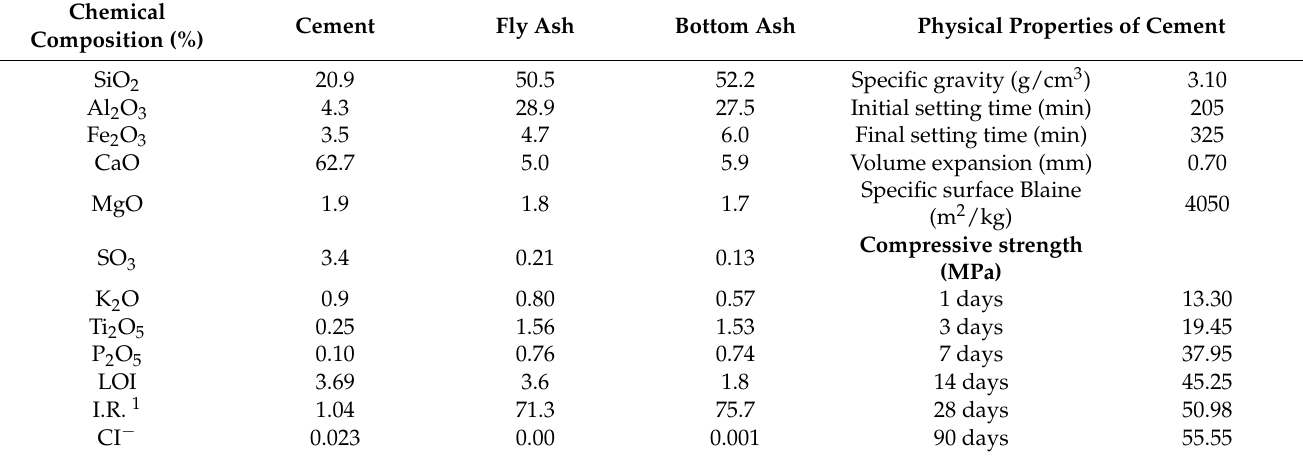
Table 1. Chemical composition of raw materials: coal bottom ash, coal fly ash, and cement